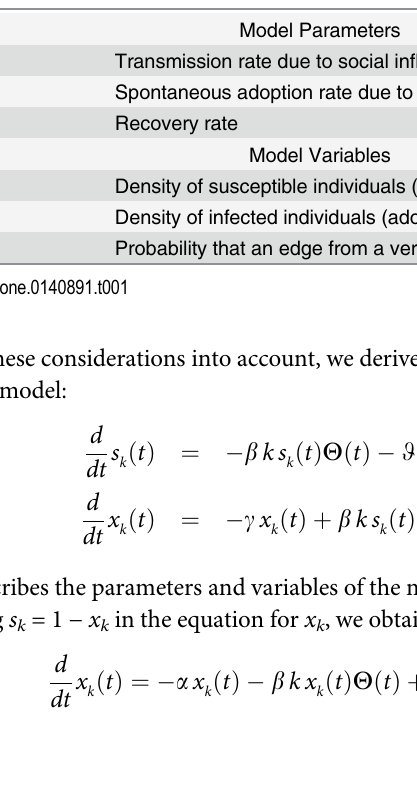
Table 1 describes the parameters and variables of the model.